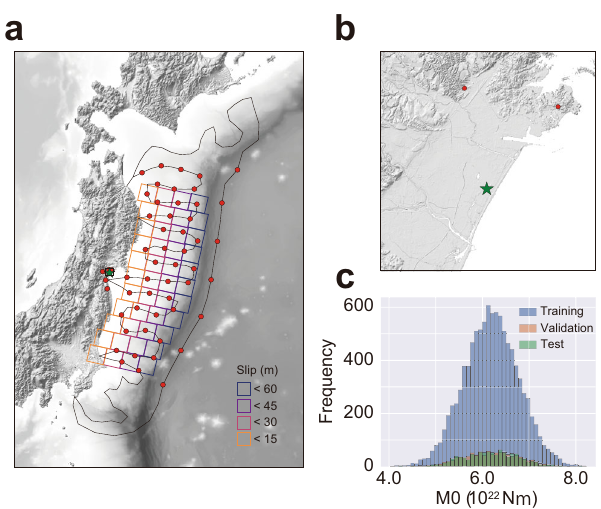
Fig. 2 Fault and observation settings for generating data sets for CNN. a Fault geometry and observation point as input for convolutional neural network (CNN). Red circles represent observation points for CNN. A total of 49 offshore tsunami observation points and fi ve onshore geodetic observation points were considered to cover the fault region and the forecasting point (the green star). Fault geometry is considered based on Fujii et al. 19 , but its slip amount is randomly assigned within a given range to generate various tsunami scenarios. b A close view of the forecasting site, the Sendai plain where experienced the large extent of tsunami inundation. The green star is the forecasting site for which the CNN forecast a tsunami inundation waveform. c Distribution of the seismic moment of generated earthquake scenarios. A total of 12,000 scenarios were generated and divided into 10,000 training sets, 1000 validation sets and 1000 test